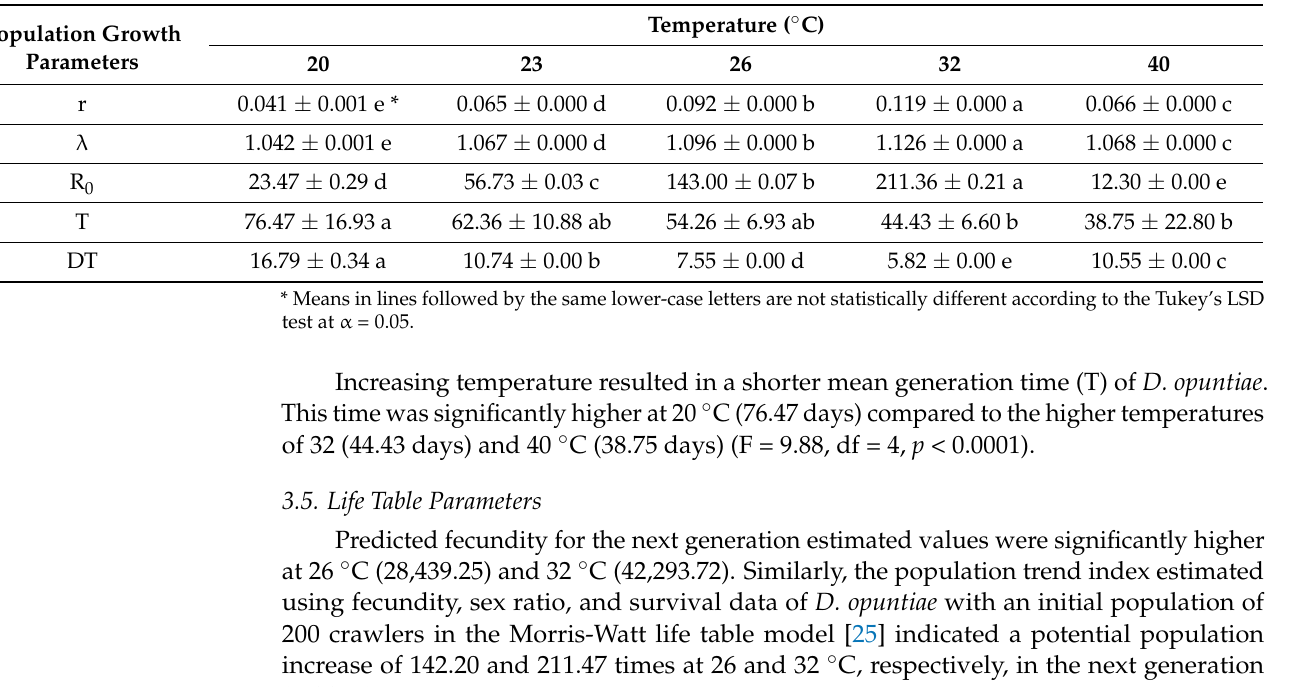
Table 4. Intrinsic rate of increase (r), finite rate of increase ( λ ), net reproductive rate (R 0 ), mean generation time (T), and doubling time (DT) of D. opuntiae under different constant temperatures (20, 23, 26, 32, and 40 ◦ C) (mean ± SE).